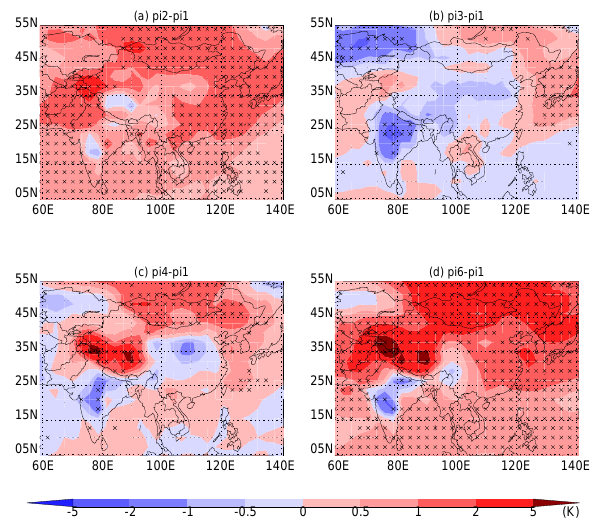
Fig. 14. Same as Fig. 13 but for Total Cloud Fraction (Unit: